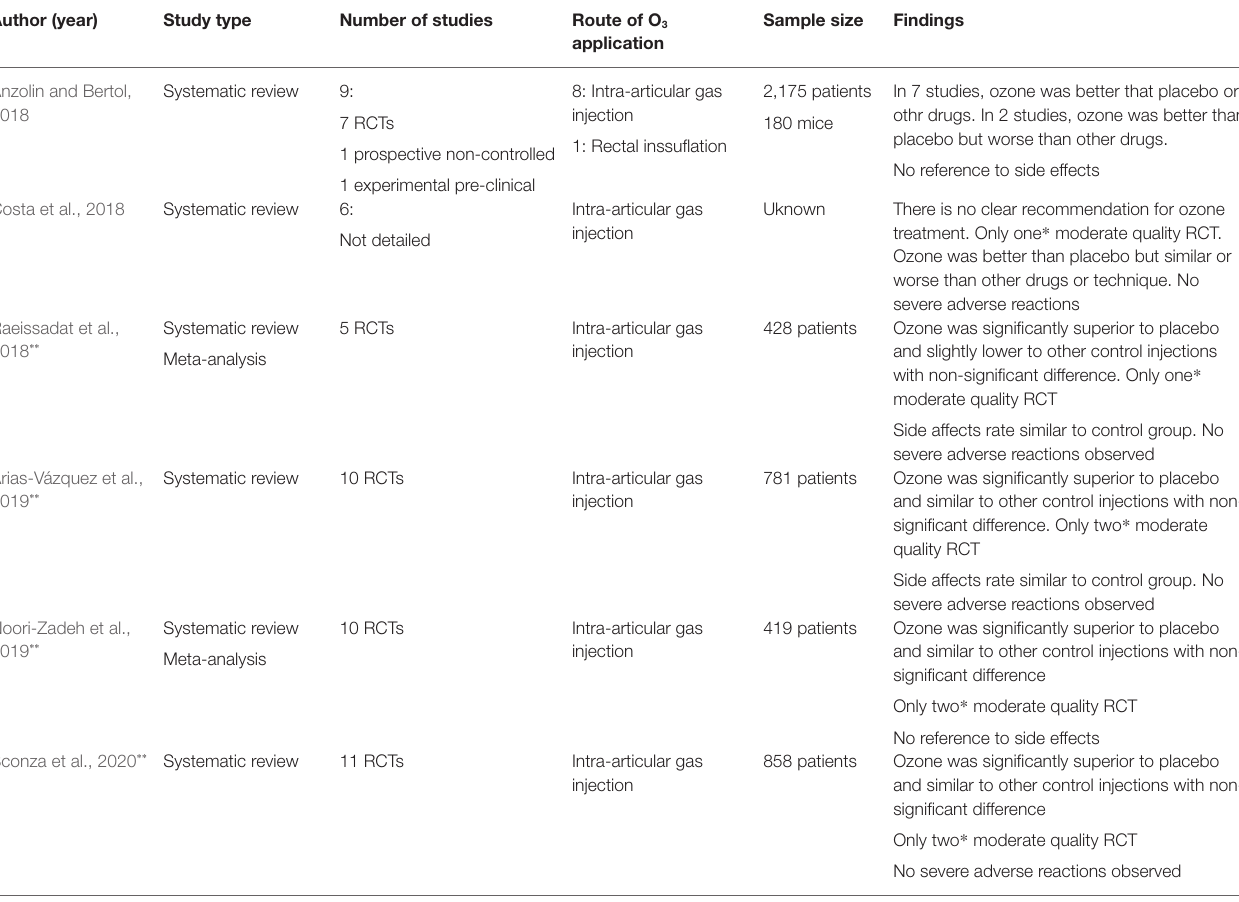
TABLE 1 | Systematic reviews and meta-analysis on medical ozone in knee osteoarthritis (Anzolin and Bertol, 2018; Costa et al., 2018; Raeissadat et al., 2018; Arias- Vázquez et al., 2019; Noori-Zadeh et al., 2019; Sconza et al.,